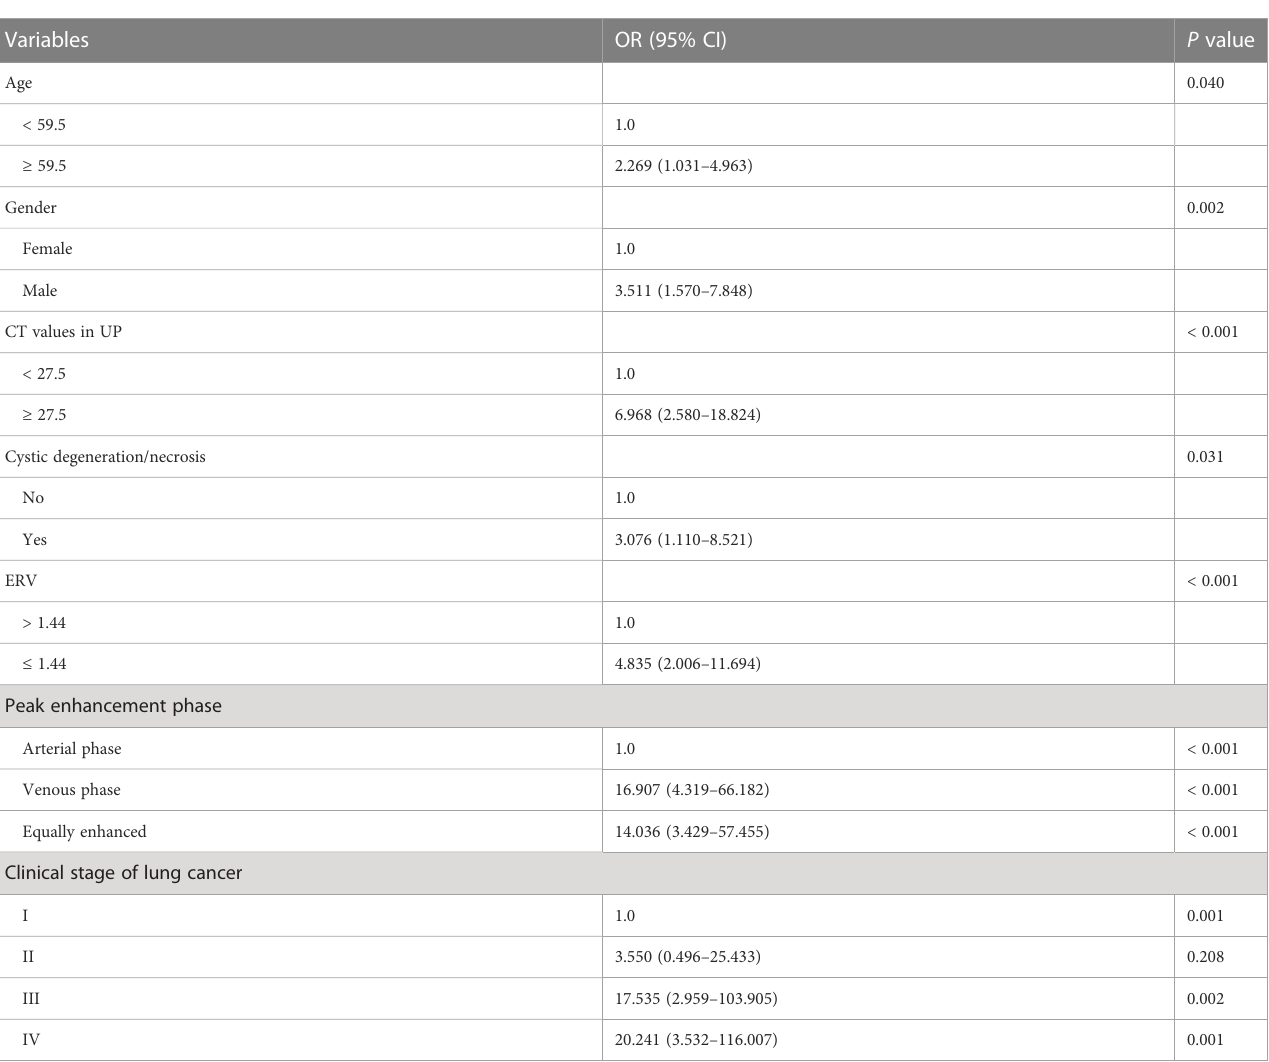
TABLE 2 Multivariate regression analysis for identifying